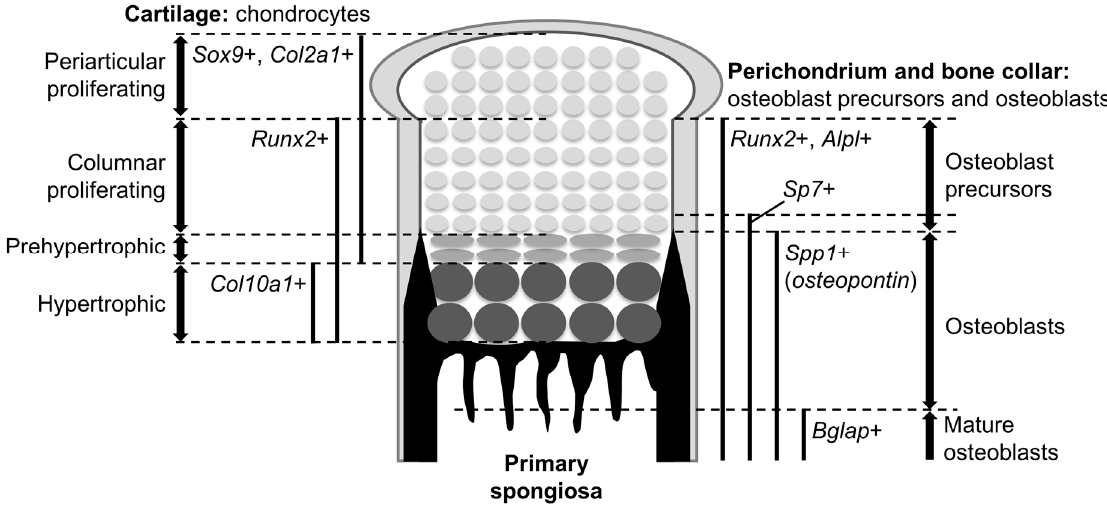
Figure 1. Structure of the growth plate in mouse embryos. An epiphysis of a fetal mouse long bone is depicted. The expression domains of marker genes and the locations of different populations are indicated (left, cartilage; right, perichondrium-bone collar).